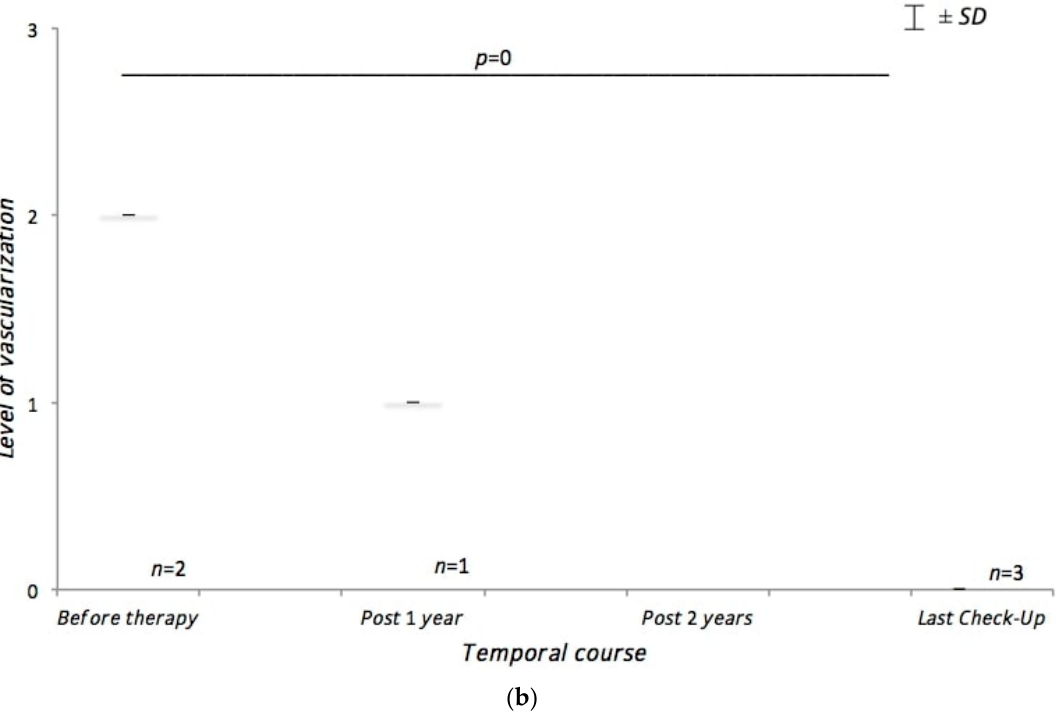
Figure 2. Course of tumor vascularization during treatment. ( a ) shows the course of choroidal melanoma vascularization using CDFIy in patients treated with CyberKnife ® . ( b ) shows the course of choroidal melanoma vascularization using CDFI in patients treated with ruthenium-106 brachytherapy.